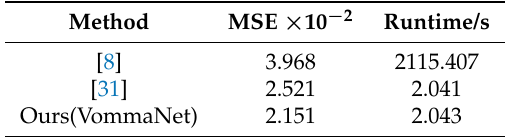
Table 1. Results comparison. Runtime is reported by author. For both scores, lower is